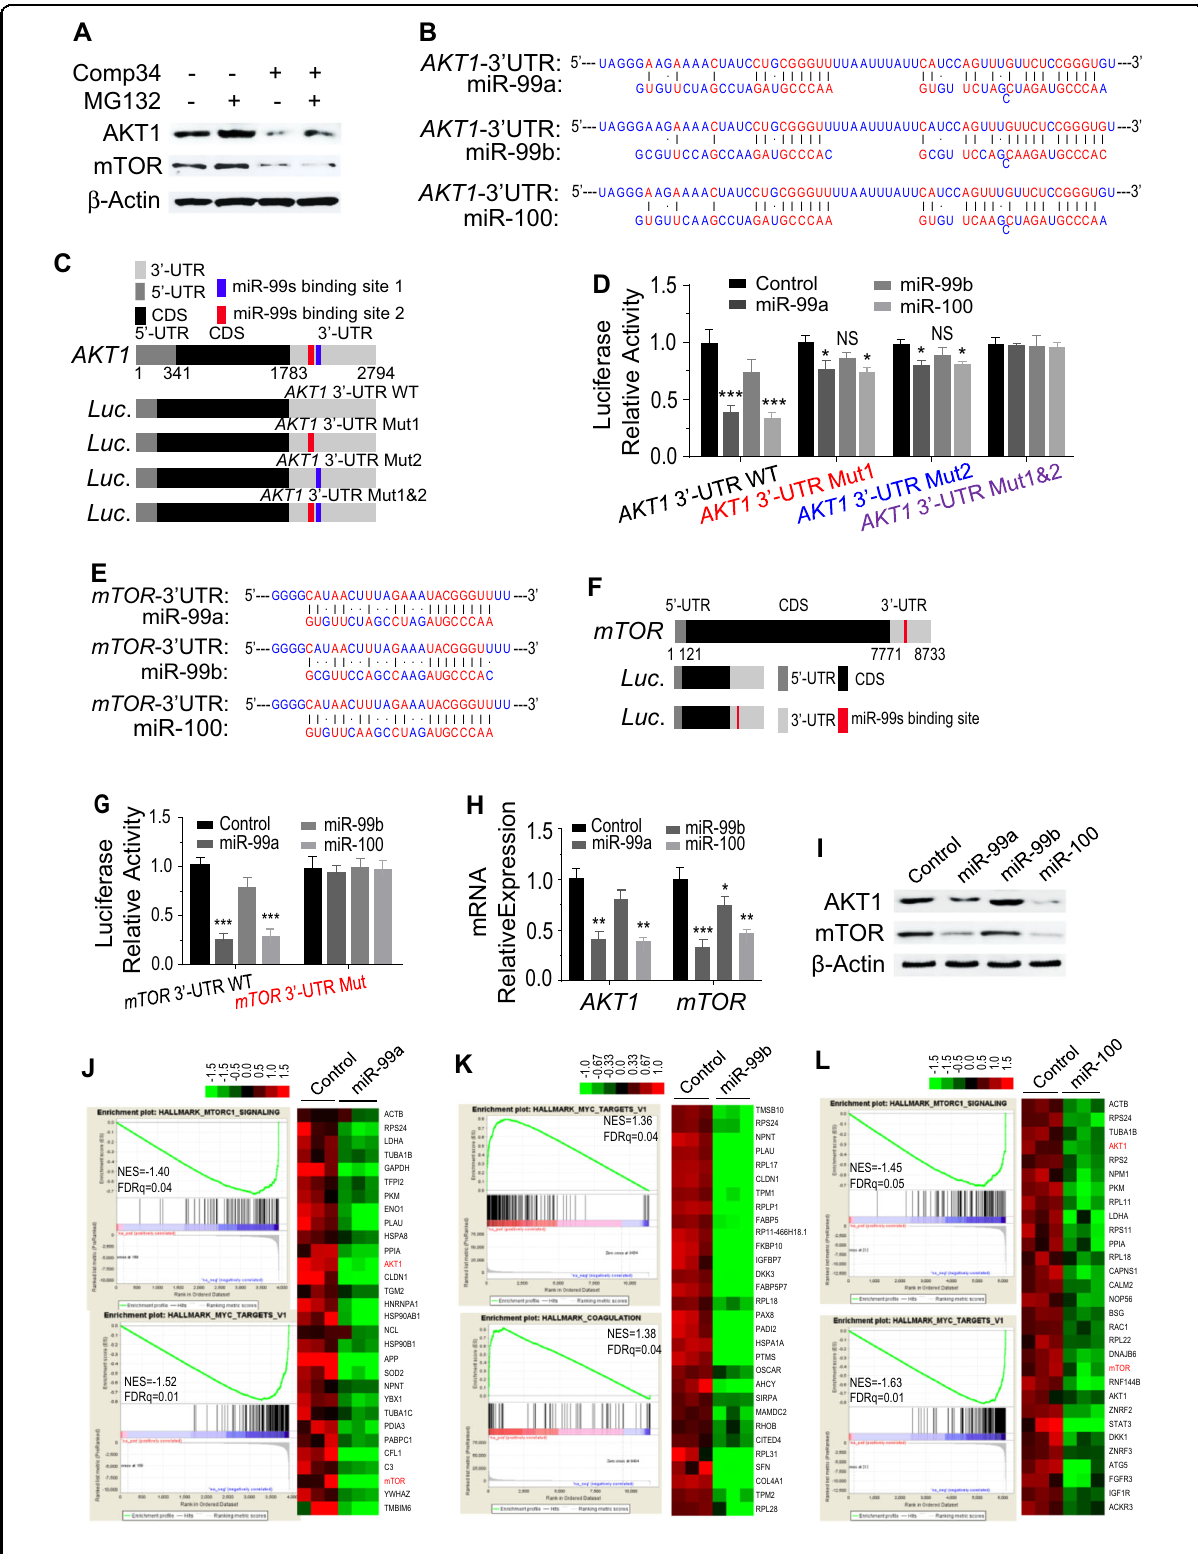
Fig. 2 (See legend on next